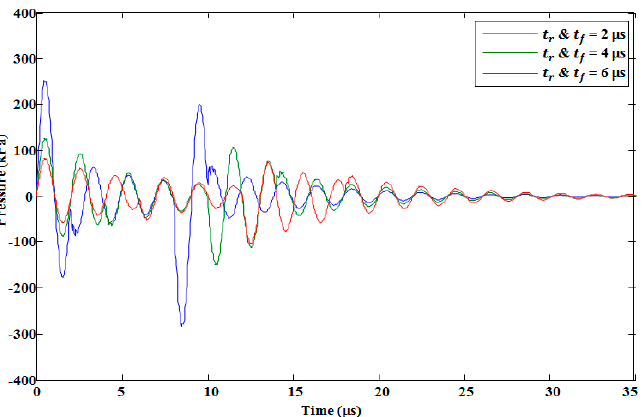
Figure 15. Effect of simultaneously changing the rising and falling time of the trapezoidal voltage waveform on the pressure in the pressure chamber.